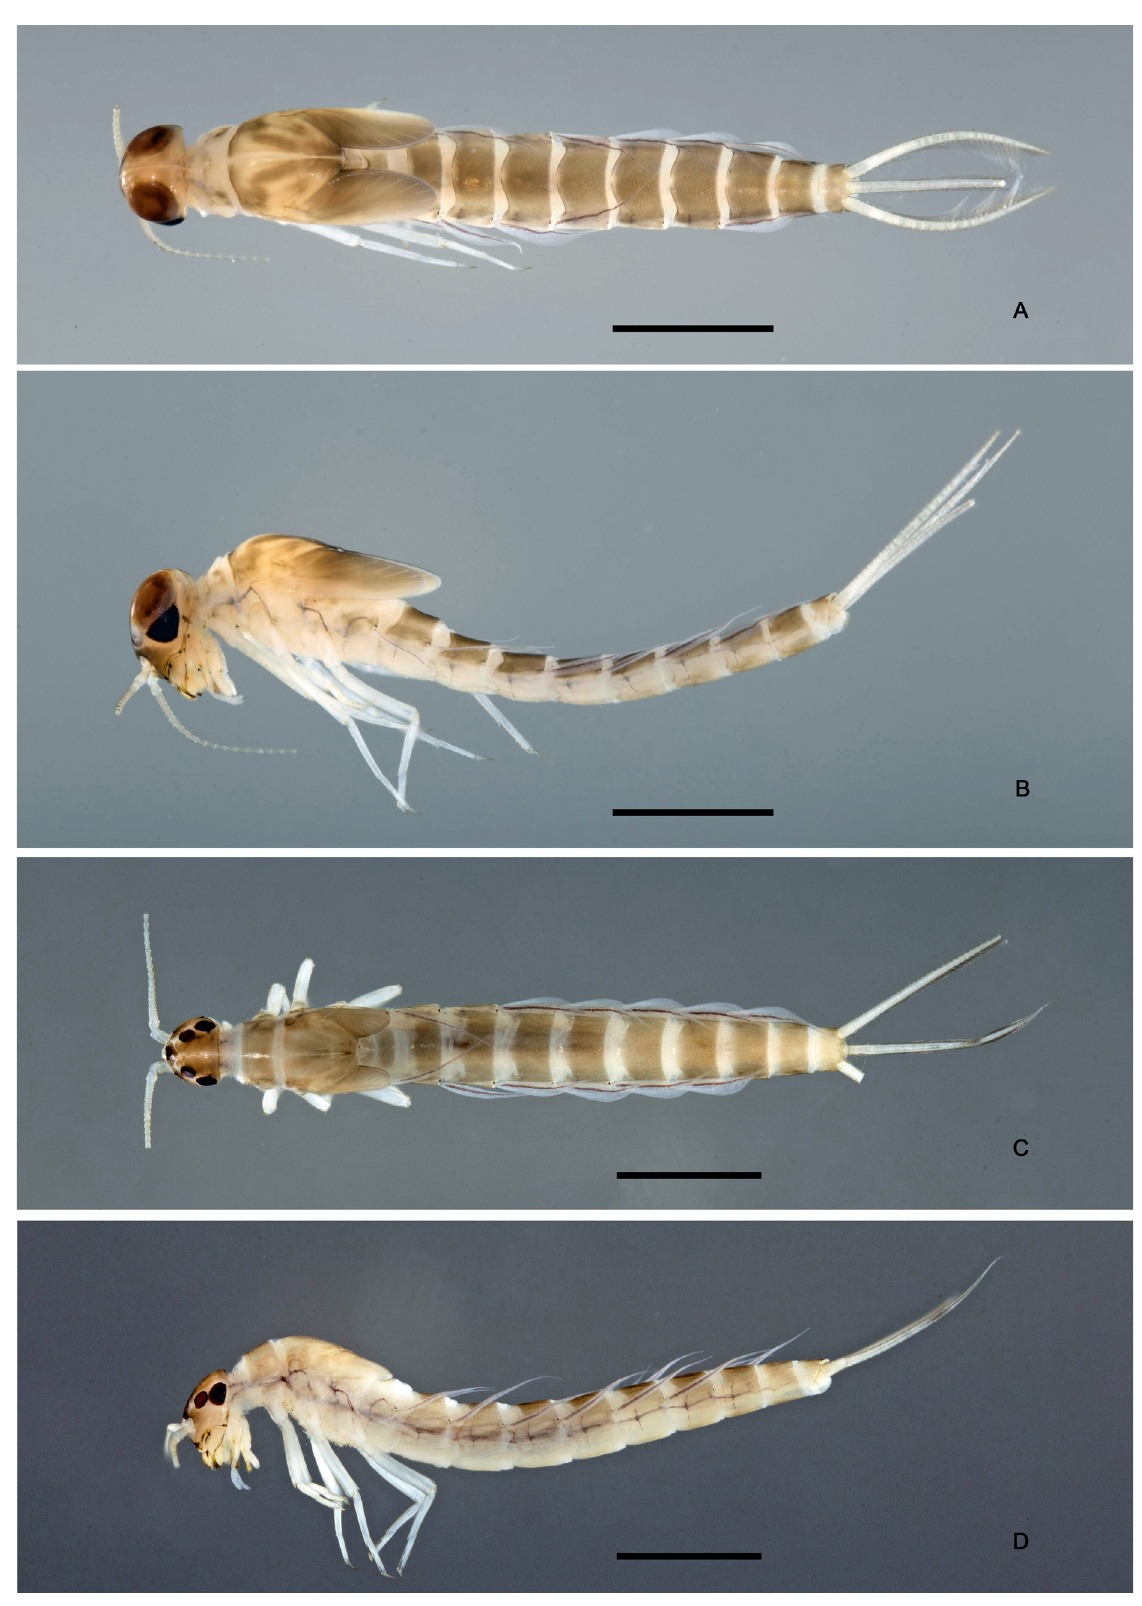
Fig. 13. Procerobaetis freitagi gen. et sp. nov., habitus, larvae. A . Dorsal view, Luzon. B . Lateral view, Luzon. C . Dorsal view, Mindoro. D . Lateral view, Mindoro. Scale bars: 1